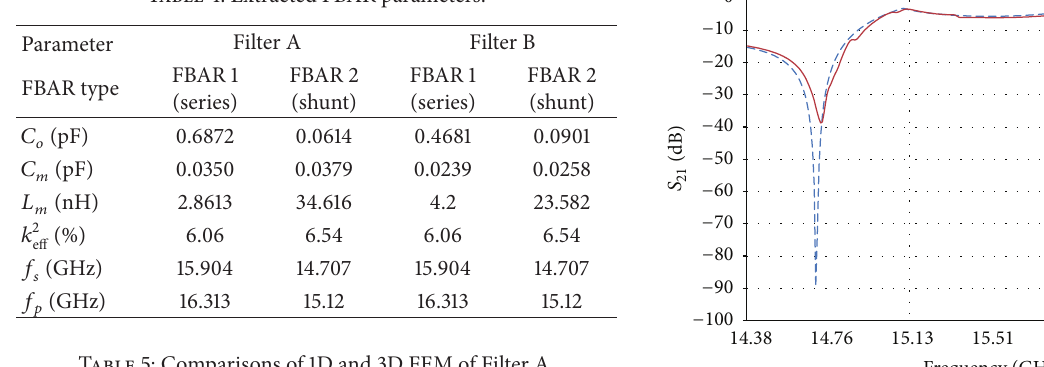
Table 4: Extracted FBAR parameters.